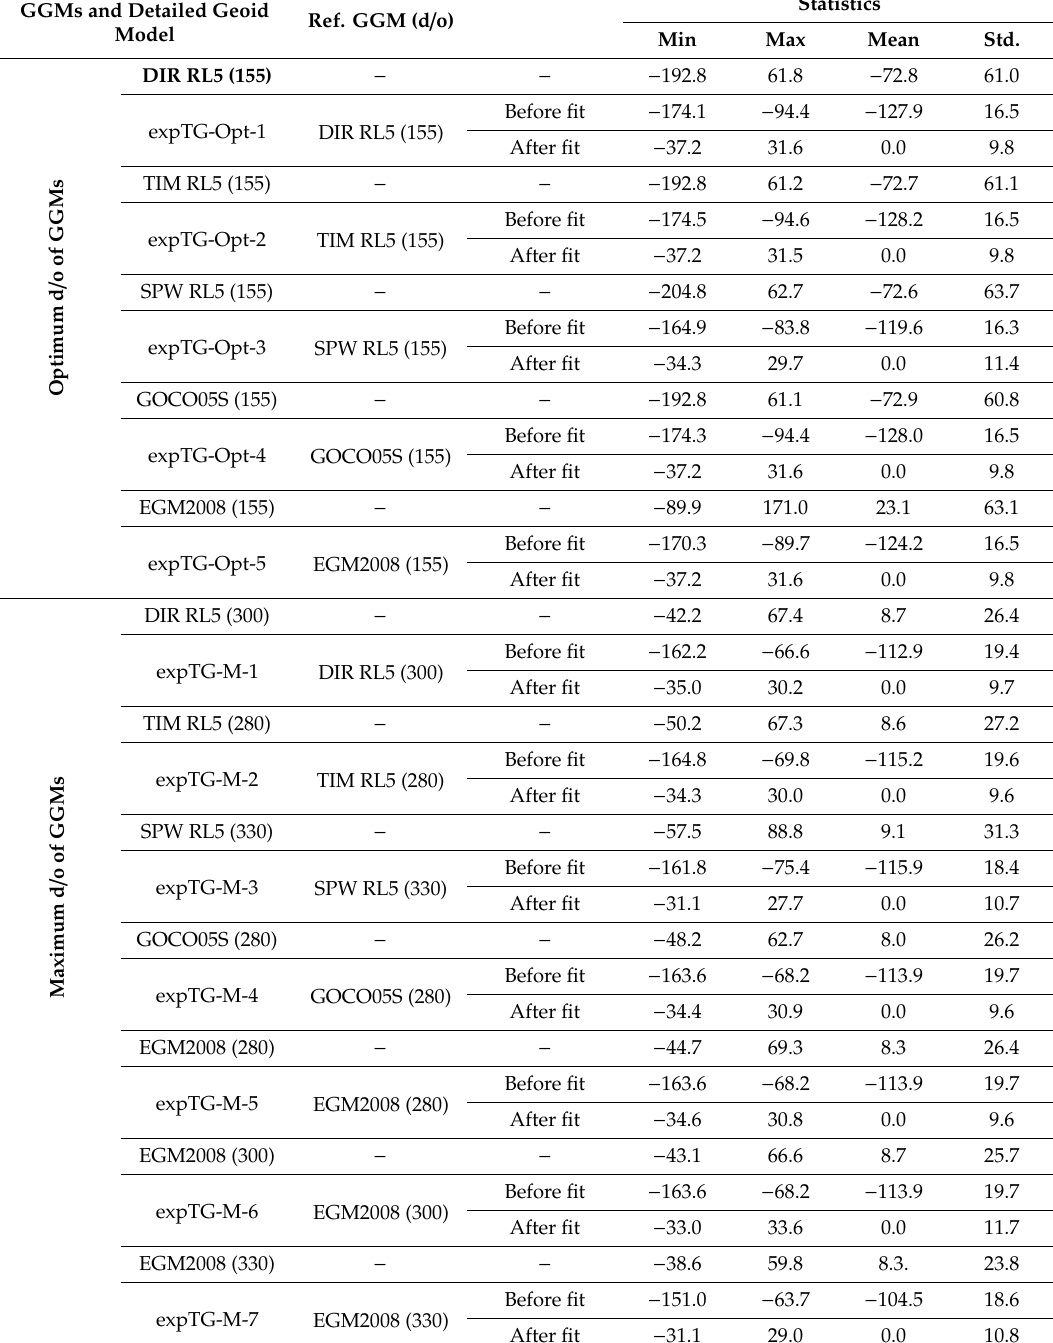
Table 3. Validation statistics of experimental geoid models at 81 GPS / leveling benchmarks (in cm). GGMs and Detailed Geoid